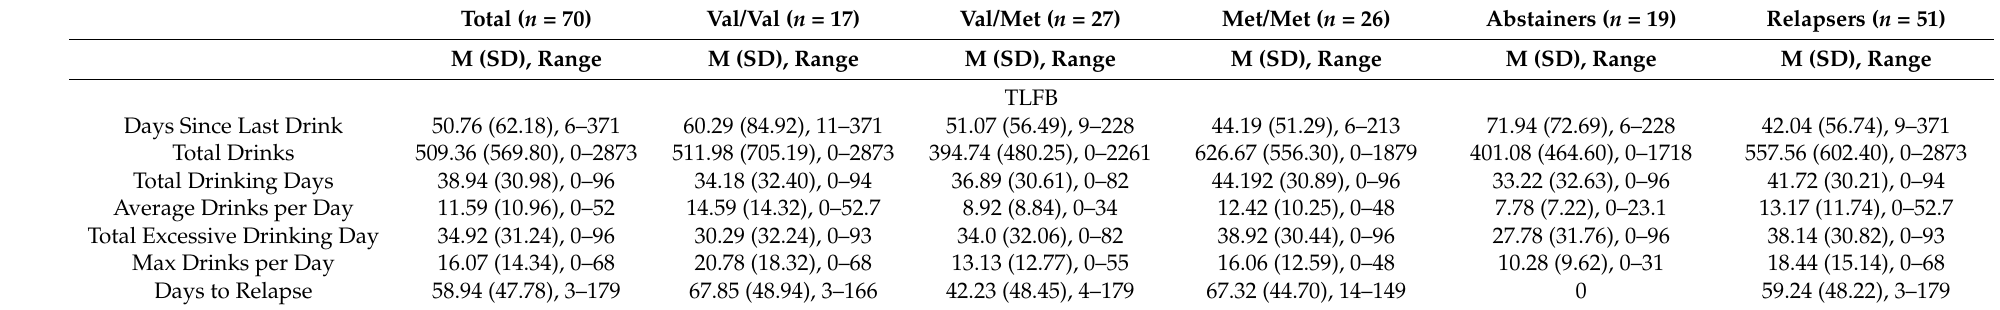
Table 4. Alcohol Timeline Followback (TFLB) by genotype and relapse status.